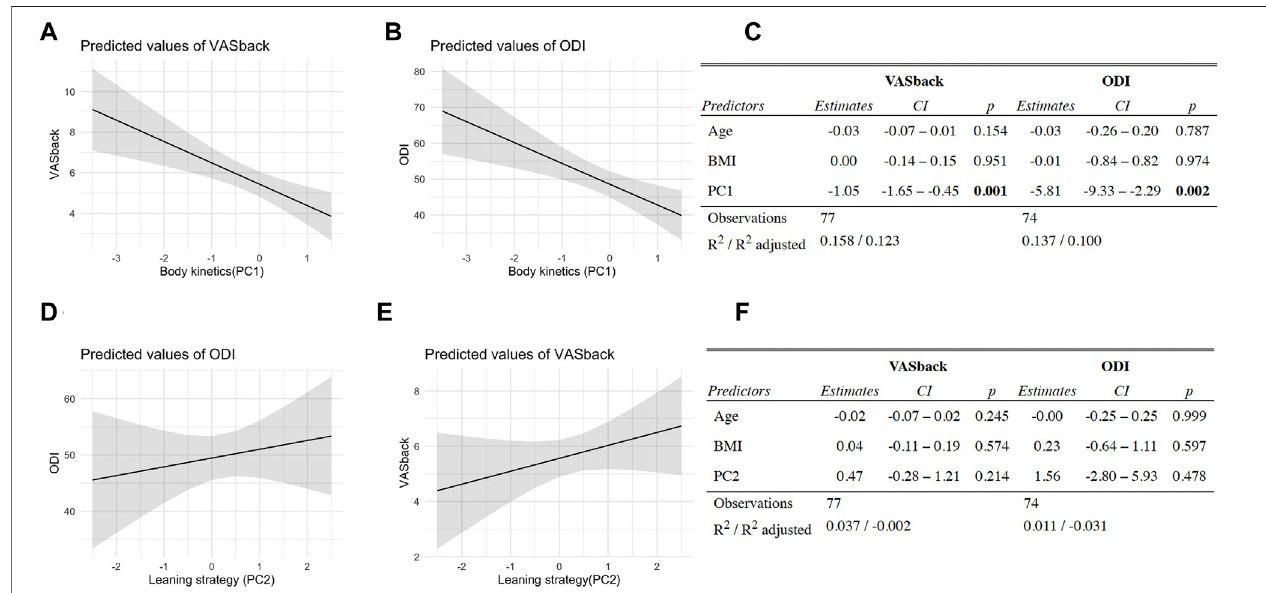
FIGURE 3 | Reduced body kinetics predict pain and disability. (A) Body kinetics (PC1 scores) vs. patient pain scores (VASback, measured using Visual Analogue Scale)linearregressionmodelplot. (B) Bodykinetics(PC1scores)vs.patient-reporteddisability(ODI,measuredusingOswestryDisabilityIndex)linearregressionmodel plot. (C) PC1 vs. VASback and ODI prediction model results. (D) Leaning strategy (PC2 scores) vs. VASback linear regression model plot. (E) Leaning strategy (PC2 scores) vs. ODI linear regression model plot. f. PC2 vs. VASback and ODI prediction model results. BMI and age were included as co-factors to correct for their potential confounding effect in the relationship between body kinetics and patient-reported